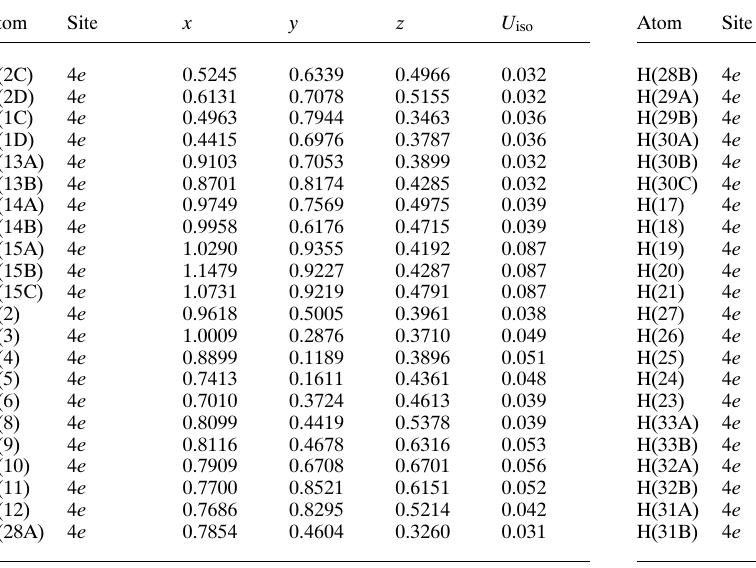
Table 2. Atomic coordinates and displacement parameters (in Å 2 )